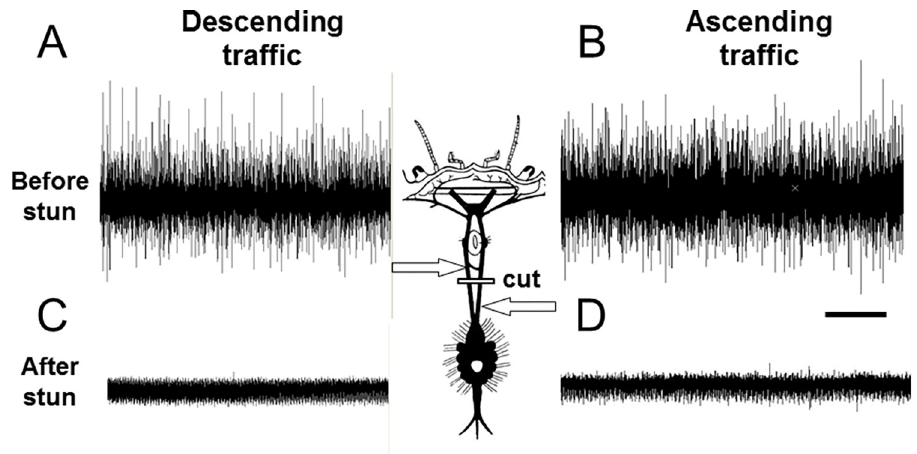
B: intact animals; C,D: 10 min after electrical stunning. Scale bar 1s.